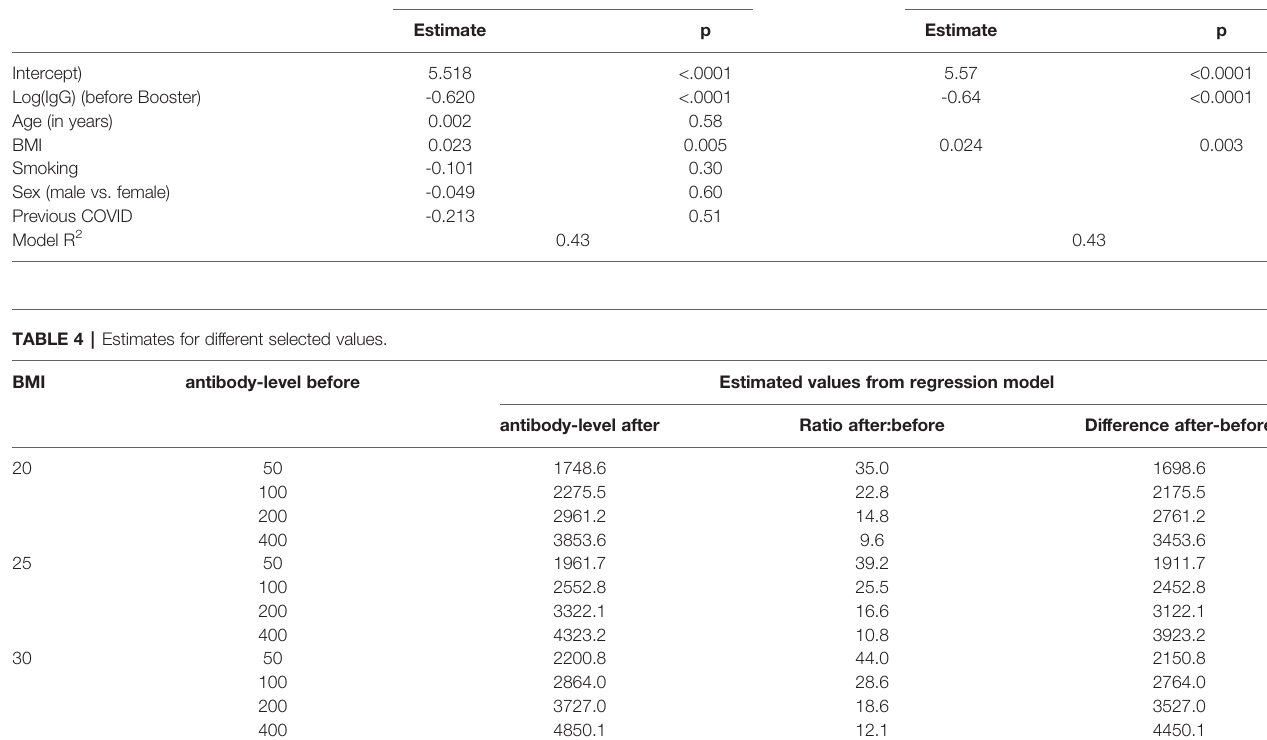
TABLE 3 | Results of the linear regression analysis. Dependent variable difference of the logarithmized IgG-levels after and before booster Independent Variables